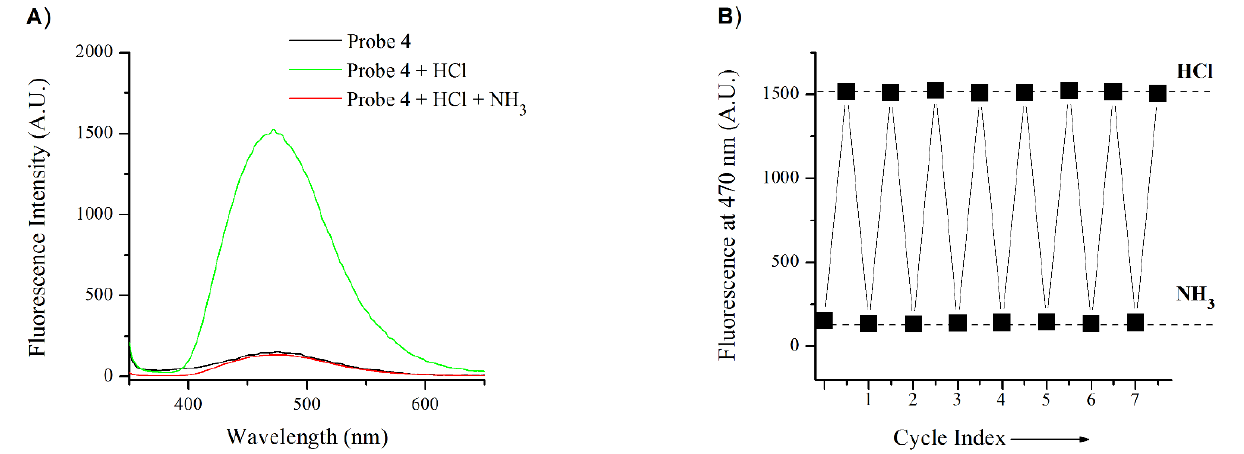
Figure 6. ( A ) Fluorescence spectra of a solid film of probe 4 , exposed first on HCl and then on NH 3 vapors ( λ ex = 340 nm); ( B ) Cycle Index of a solid film of probe 4 .